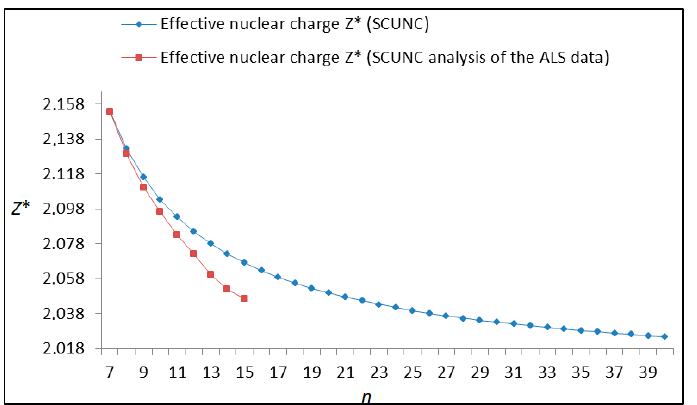
Figure 16. Variations of the effective nuclear charge Z* with the principal quantum number n for the 4 s 2 4 p 2 ( 1 D 2 ) ns Rydberg series originating from 2 P ° 1/2 metastable state of Se + converging to the 1 D 2 series limits in Se 2+ . ** Energy differences relative to the ALS experimental data. Table 9. Energy resonances ( E ), quantum defect ( δ ) and effective charge ( Z *) of the 4 s 2 4 p 2 ( 3 P 2 ) nd Ry- dberg series originating from the 4 s 2 4 p 3 2 D° 3/2 metastable state of Se + converging to the 3 P 2 series limit in Se 2+ . The present results (SCUNC) are compared with the experimental data from ALS measurements [6]. The uncertainties in the experimental energies are stated to be ±0.010 eV, f 1 ( 3 P 2 ; 2 D° 3/2 ) = − 0.094 ± 0.042 with ν = 11.